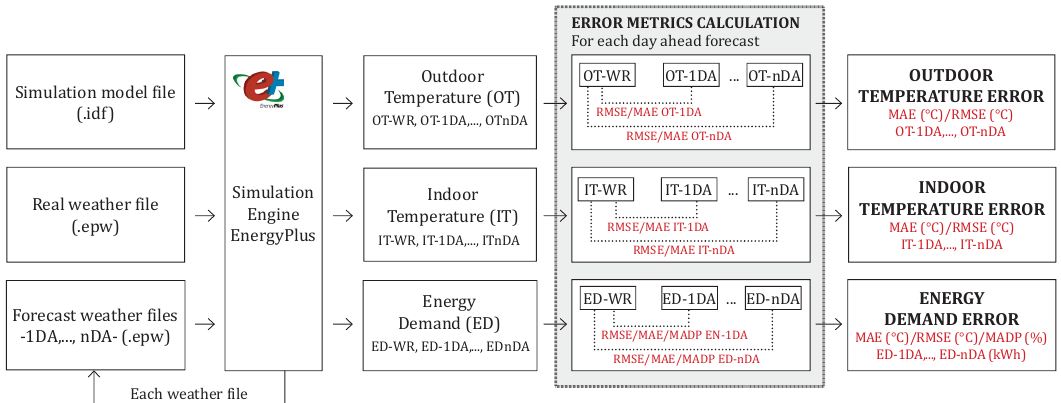
Figure 8. Building energy model (BEM) simulation and error metrics calculation